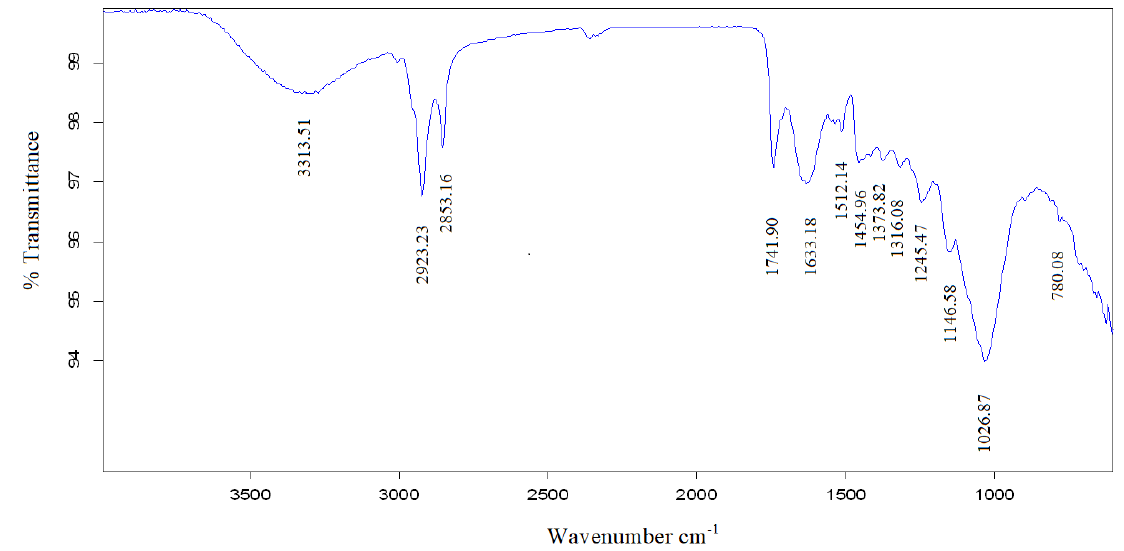
Figure 6. FTIR spectrum for AR adsorbents after adsorption of oil. Table 2. FTIR spectrum of ASs adsorbents before and after adsorption process of oil.